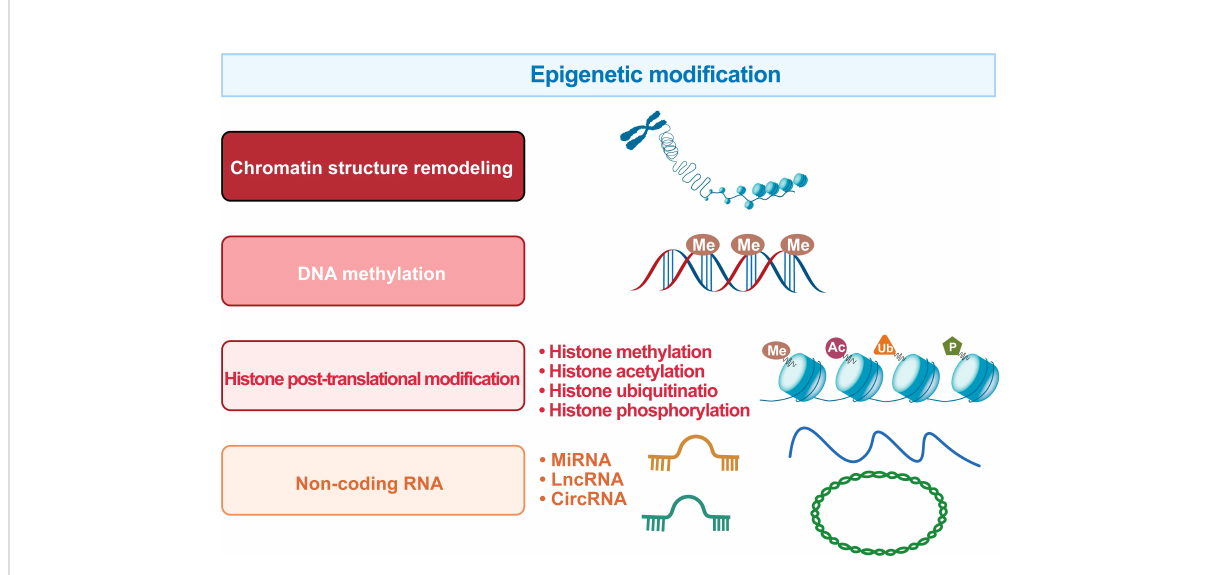
FIGURE 5 The regulatory systems involved in the epigenetic landscape of HCC. The epigenetic marks in HCC include chromatin structure remodeling, DNA methylation, histone post-translational modi fi cation and non-coding